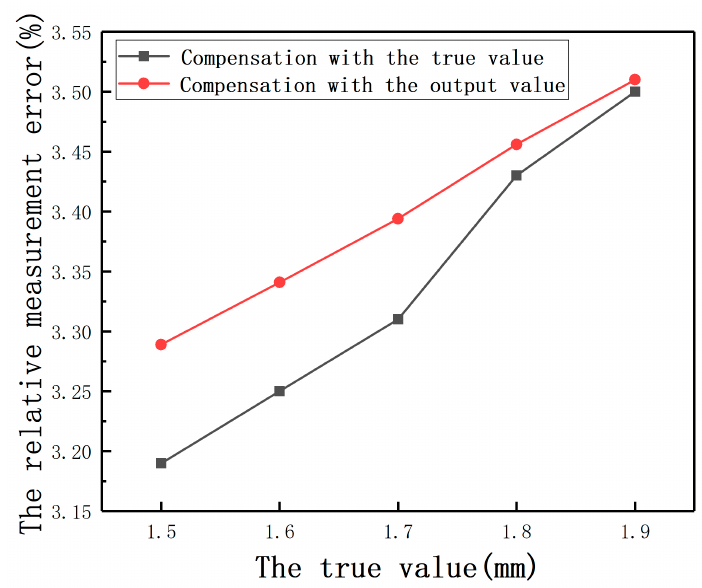
Figure 37. The relative measurement errors after compensation with the true value and the output value.